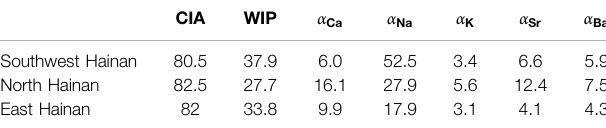
TABLE 2 | Proxies for the chemical weathering intensity of the Hainan riverine sediments.